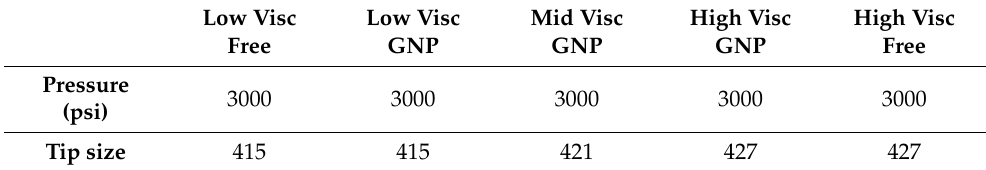
Table 6. Spraying characteristics for each